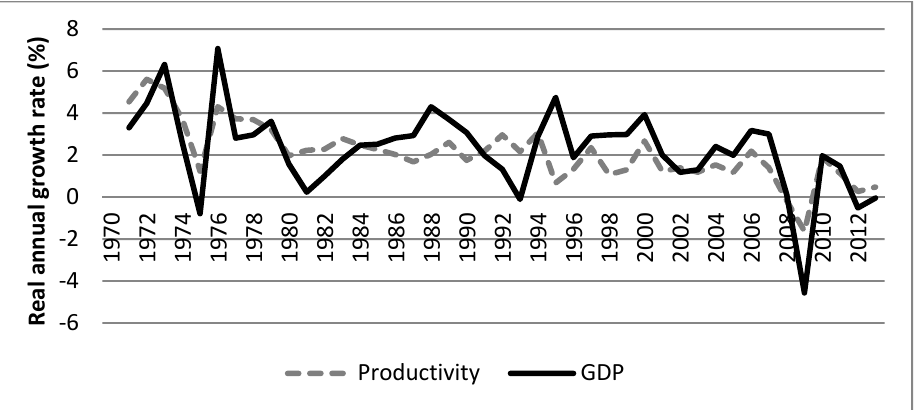
Source: own elaboration from OECD data.